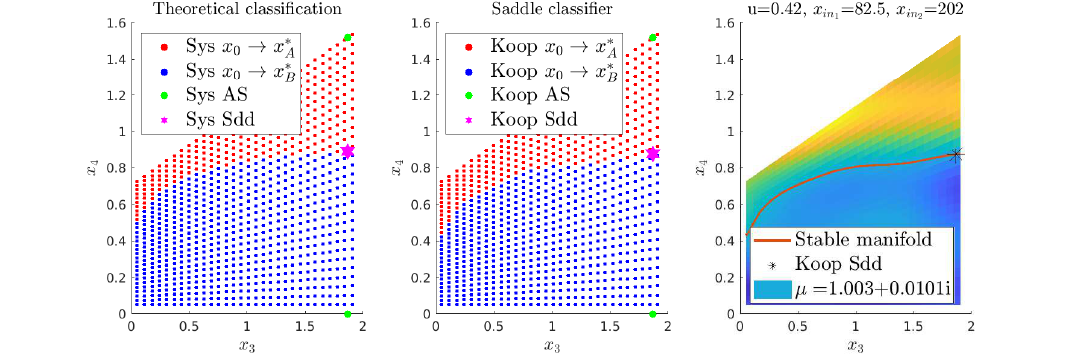
Figure 9: Theoretical, saddle based classification of initial conditions, and eigenfunction with the corresponding saddle point and stable